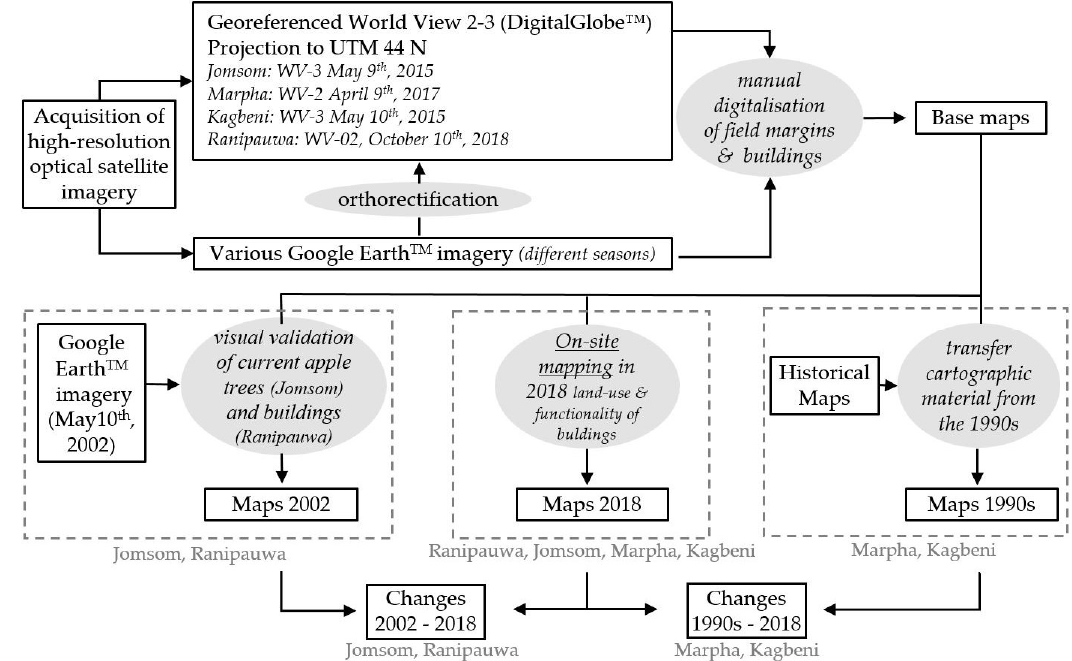
Figure 4. Schematic view of methodological steps applied within this